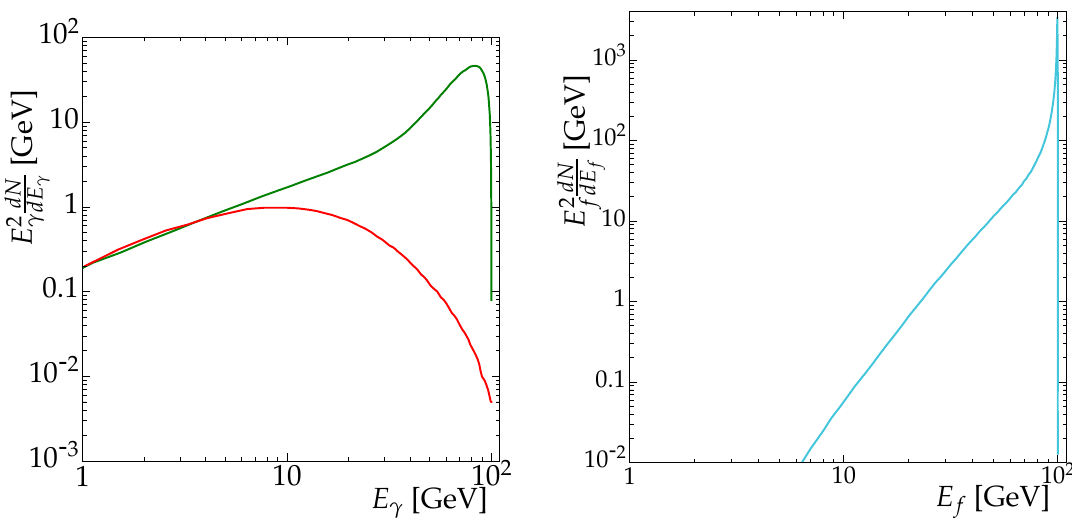
Figure 4 . Energy spectrum of the prompt (cid:13) -ray (left) and the bottom-quark (right) for the process (cid:31)(cid:31) ! b (cid:22) b(cid:13) . The continuous red-line on the top panel denotes the (cid:13) -ray spectrum from the b -quark decay. In these plots we set d 6 = 1, d 8 = 1, v = 10 (cid:0) 3 c , m (cid:31) = 100 GeV, and (cid:3) = 1 TeV. (cid:31)(cid:31) ! b (cid:22) b(cid:13) . The continuous green line in the top panel of (cid:12)gure 4 depicts the spectrum of the prompt photon, while the continuous red line shows the spectrum of the photons emitted from the (cid:12)nal state bottom quark. In (cid:12)gure 4, we use the dark matter particle mass as m (cid:31) = 100 GeV, (cid:3) = 1 TeV, d 6 = d 8 = 1, and v = 10 (cid:0) 3 c